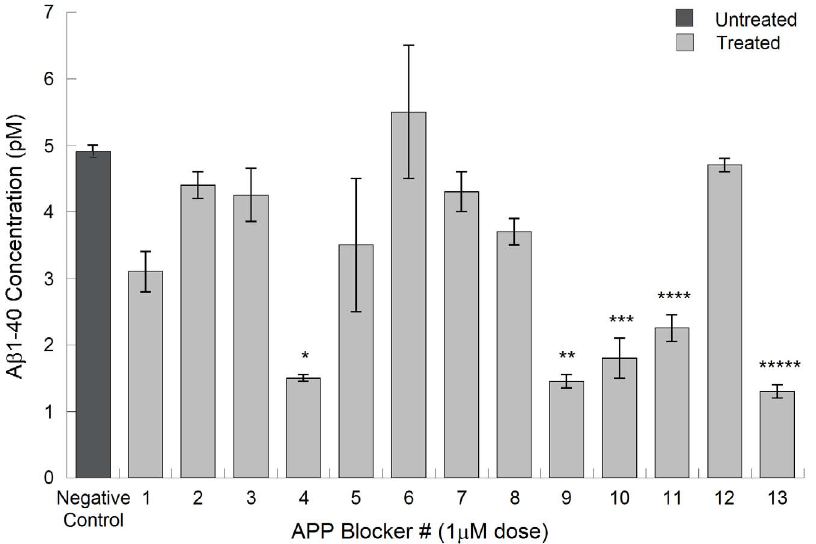
Figure 2. Relative capacity of thirteen APP 5 9 UTR translation blockers to reduce A b levels in the conditioned medium of SH-SY5Y cells. Following 48 h treatment (1 m M) for each inhibitor, the histogram shows reduction of total A b levels confirmed after averaging five independent samplings from the following:- JTR-009 treated , control, p , 0.01). Total A b levels were also documented for the APP blockers JTR-004, JTR-10, JTR-0011 JTR-0013 (N=5). Data are means 6 SEM, N=5, *=p , 0.01, **=p , 0.01, ***=p , 0.0013, p , 0.01, **** p , 0.011, *****, where each treatment was analyzed by ANOVA + Dunnett’s post hoc test compared to untreated samples. JTR-009 was the ninth and JTR-005 was fifth in the series of 13 APP translation